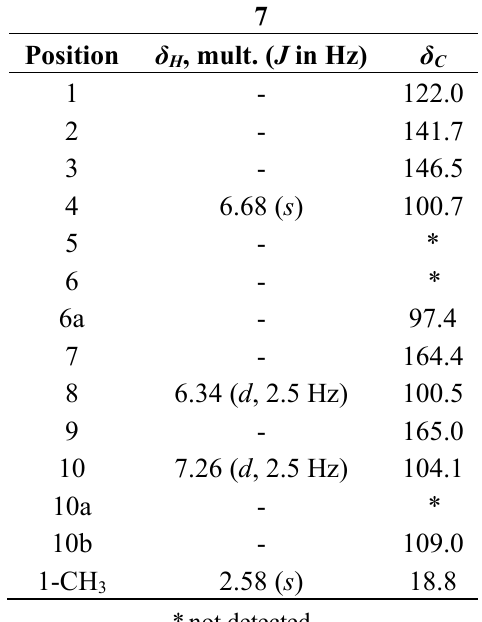
Table 1. 1 H (500 MHz) and 13 C-NMR (125 MHz) spectral data for 7 in DMSO -d